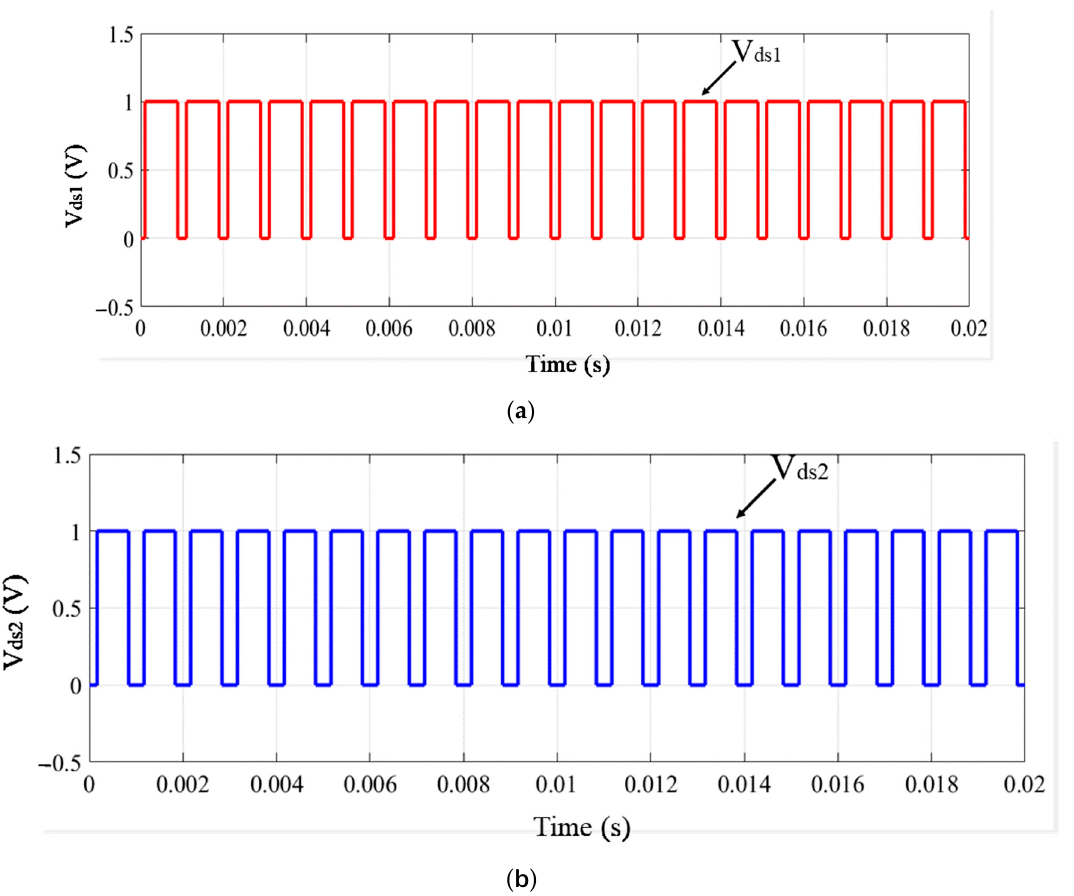
Figure 7. Simulation response of input voltage waveform.